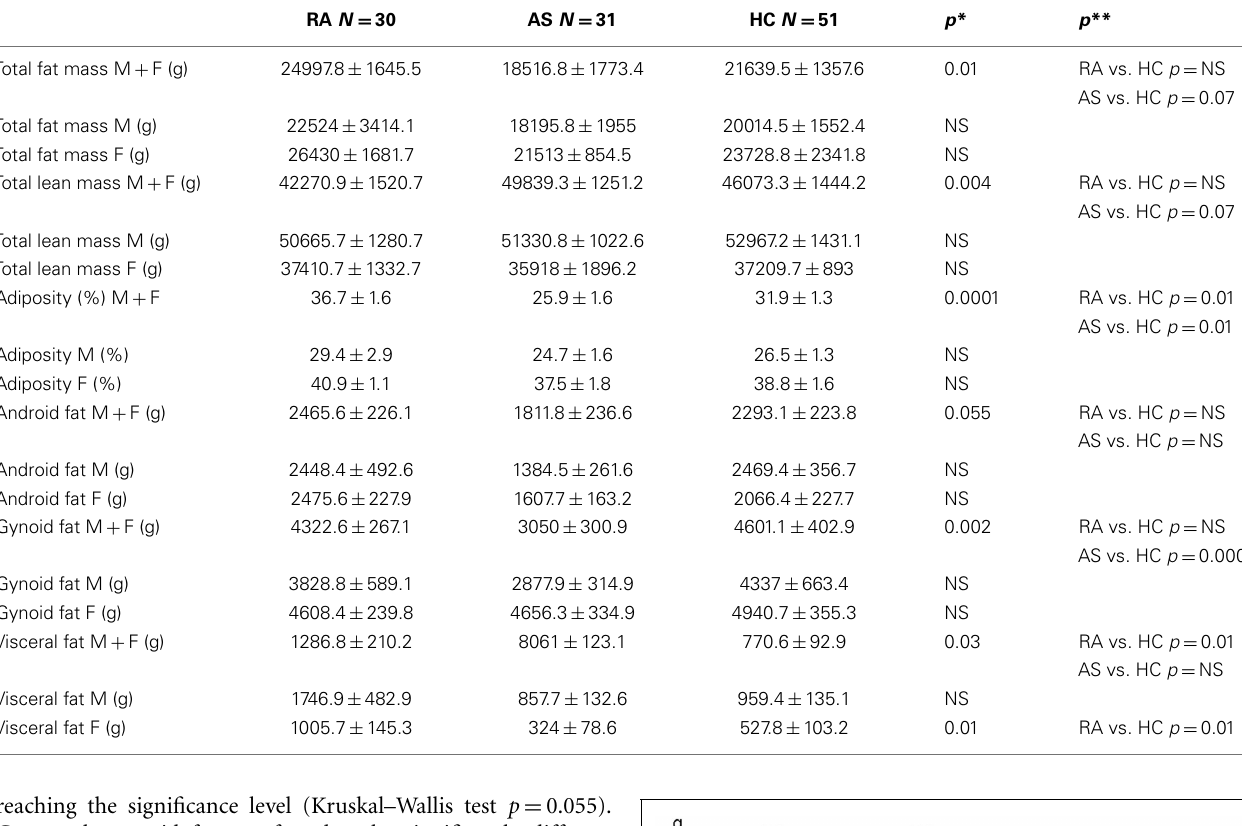
Table 3 | Body composition measurements of patients with rheumatoid arthritis (RA), ankylosing spondylitis (AS), and healthy controls (HC) (M, male; F, female; *Kruskal–Wallis test; **Mann–Whitney test) .